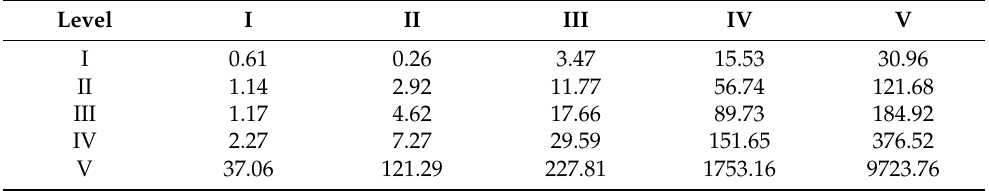
Table 5. Areas (ha) of misclassification of the five coverage levels derived from FVC 250m values.